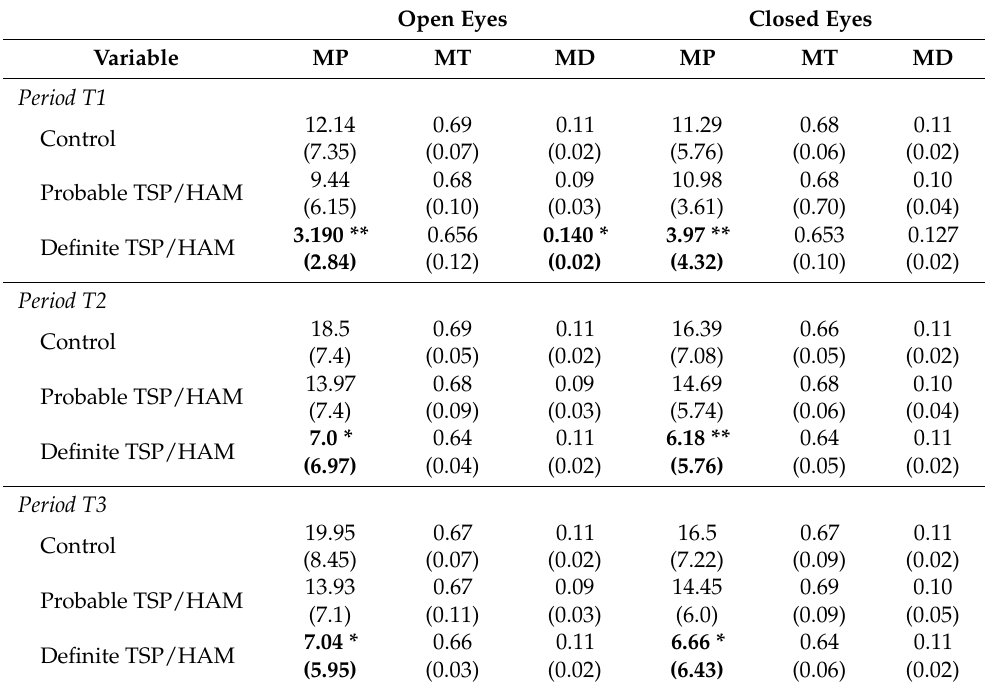
Table 3. The mean (standard deviation) of the structural variables of the displacement of the COP. Open